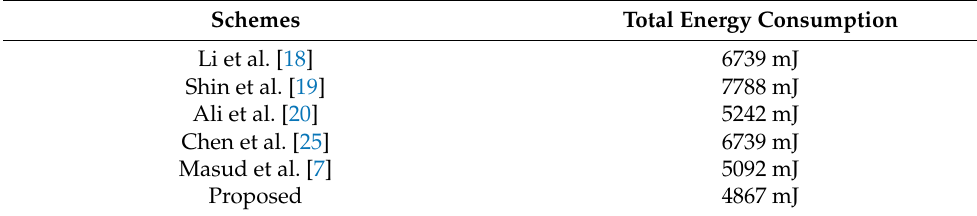
Table 6. Comparison of energy